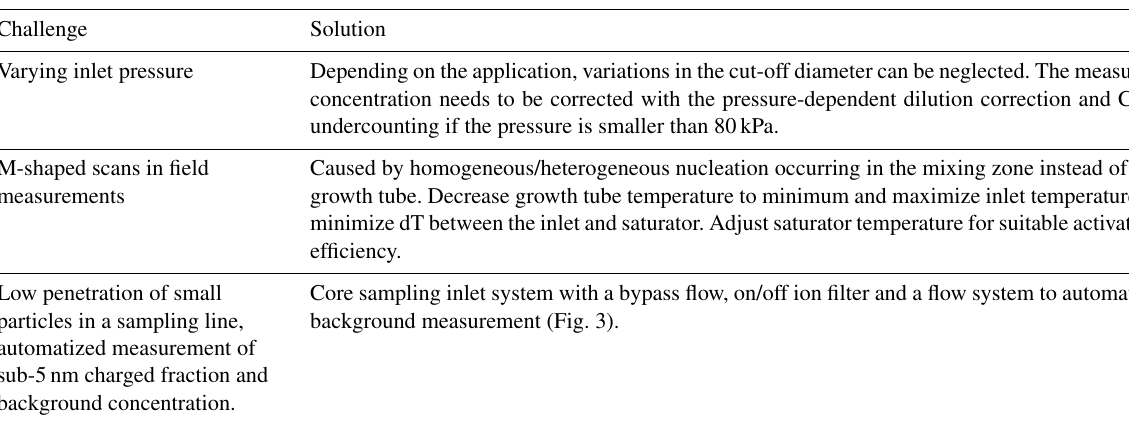
Table 1. Brief compilation of challenges and solutions explored in this study. Challenge Solution Varying inlet pressure Depending on the application, variations in the cut-off diameter can be neglected. The measured concentration needs to be corrected with the pressure-dependent dilution correction and CPC undercounting if the pressure is smaller than